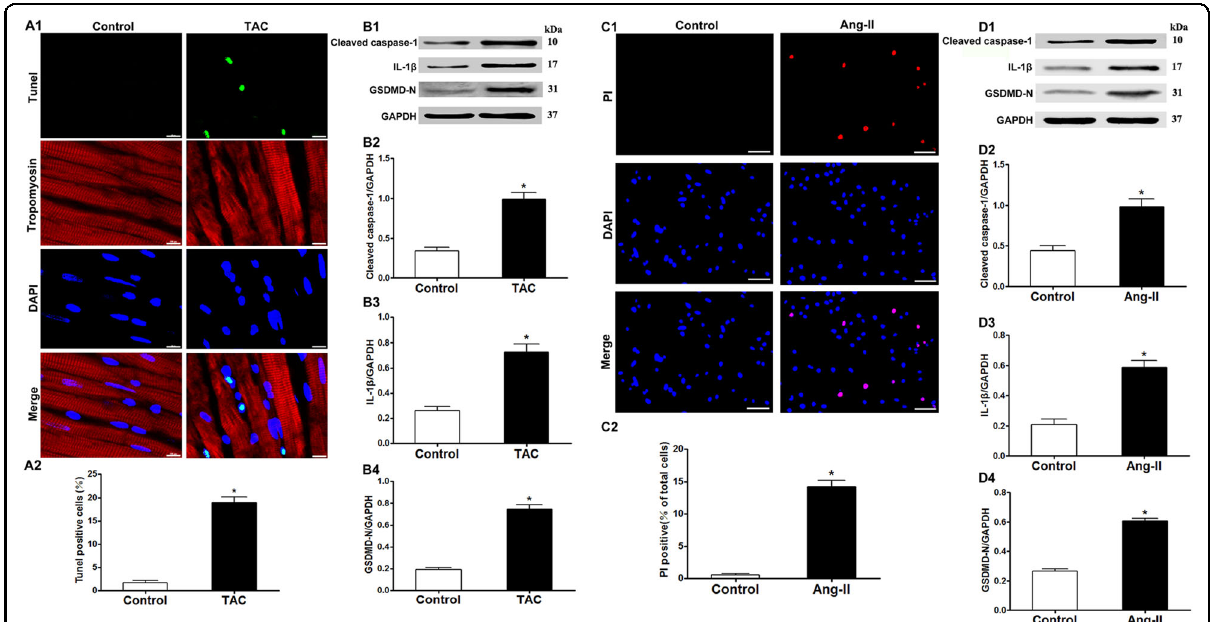
Fig. 1 TAC and Ang-II, respectively, induce pyroptosis in myocardial tissue and cultured cardiomyocytes. A1 Representative images showing TUNEL + pyroptotic cardiomyocytes. Red — anti-tropomyosin, blue nuclei — DAPI, green nuclei — TUNEL. Scale bars: 100 μ m. A2 Percentage of TUNEL- positive cells in the indicated groups. B Immunoblots showing the levels of cleaved caspase-1 ( B1, B2 ), IL-1 β ( B1 , B3 ), and GSDMD-N ( B1 , B4 ) in the indicated groups. C1 Representative images showing PI-stained pyroptotic cardiomyocytes with/out Ang-II treatment. Blue nuclei — DAPI, red nuclei — PI. Scale bars: 200 μ m. C2 Percentage of PI-positive cells in the indicated groups. D Immunoblots showing levels of cleaved caspase-1 ( D1 , D2 ), IL- 1 β ( D1, D3 ), and GSDMD-N ( D1 , D4 ) in the suitably treated cardiomyocytes. Results are mean ± SEM, n = 6. * P < 0.01 compared to